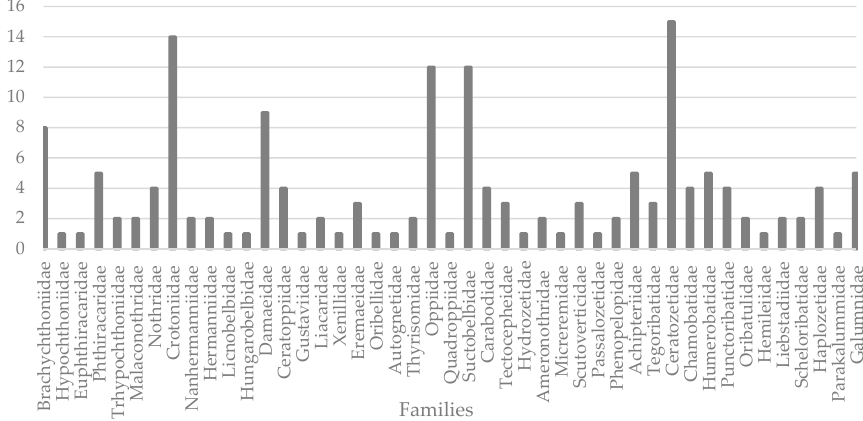
Figure 2. Distribution of species richness among di ff erent families of oribatid mites in the East European tundra (taxa are in a systematic order).